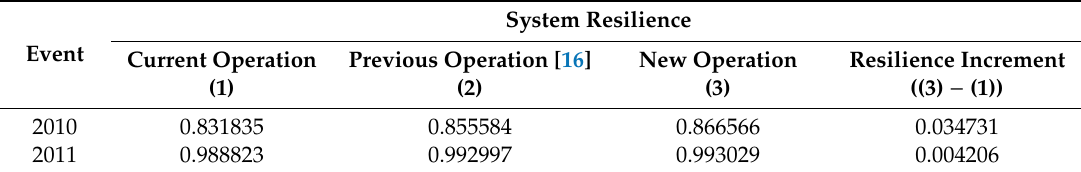
Table 4. Results of system resilience for each